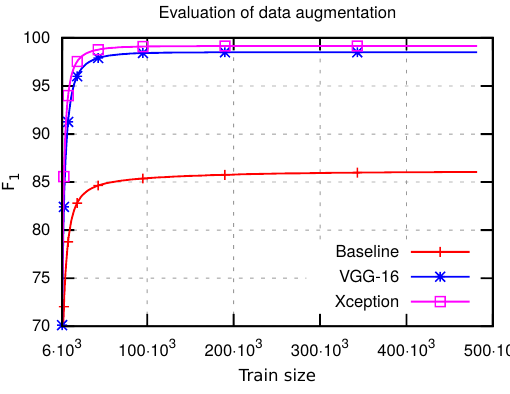
Figure 4. F 1 varying the data augmentation size with VGG-16, Xception, and the Baseline